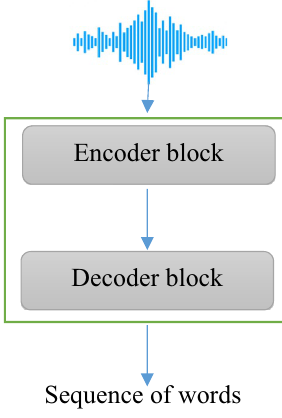
Figure 1. General scheme of the